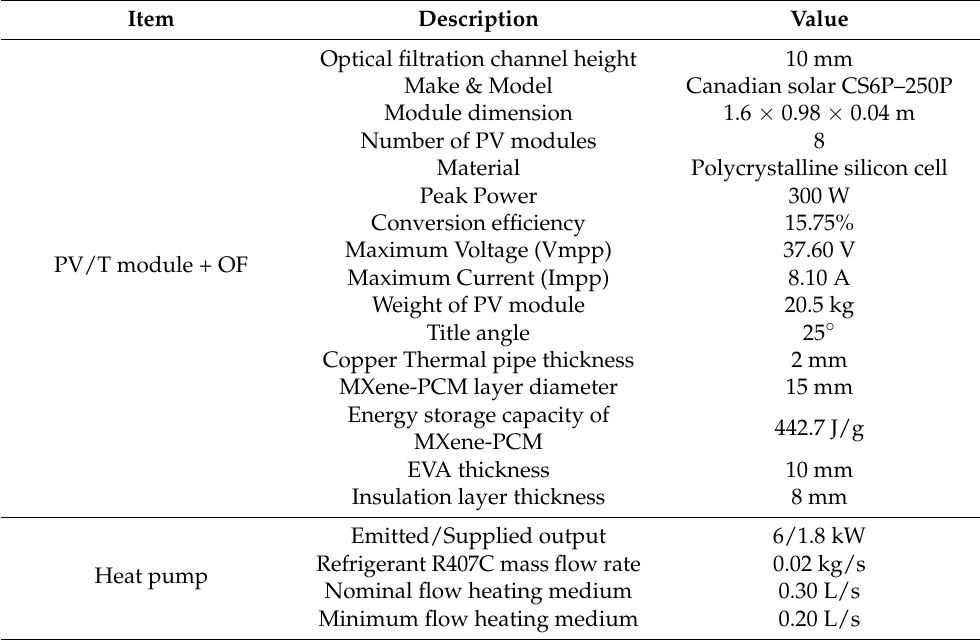
Figure 4. Diagram of system components. Table 1. System parameters [35,36].